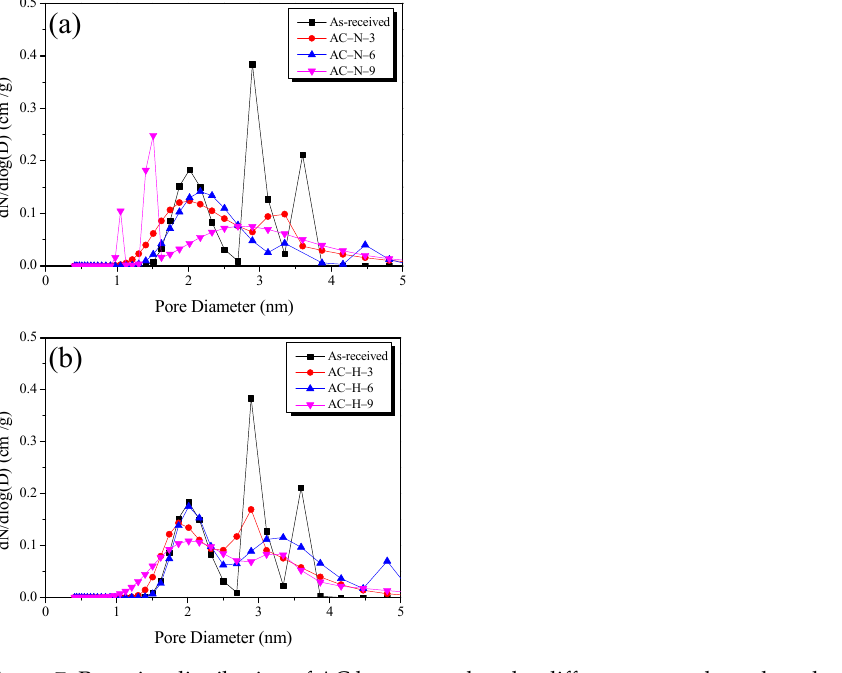
Figure 7. Pore size distribution of AC heat-treated under different atmospheres based on the NLDFT method: ( a ) N 2 ; ( b ) H 2 /N 2 mixed gas.